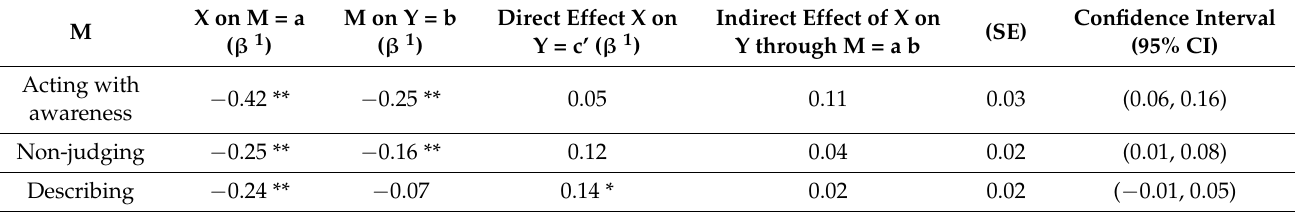
Table 4. Path Analysis with Logistic Regression (PALR) and the effect of mindfulness factors (M) mediation on the relation between impulsiveness (X) and job stressfulness perception (Y) ( n =